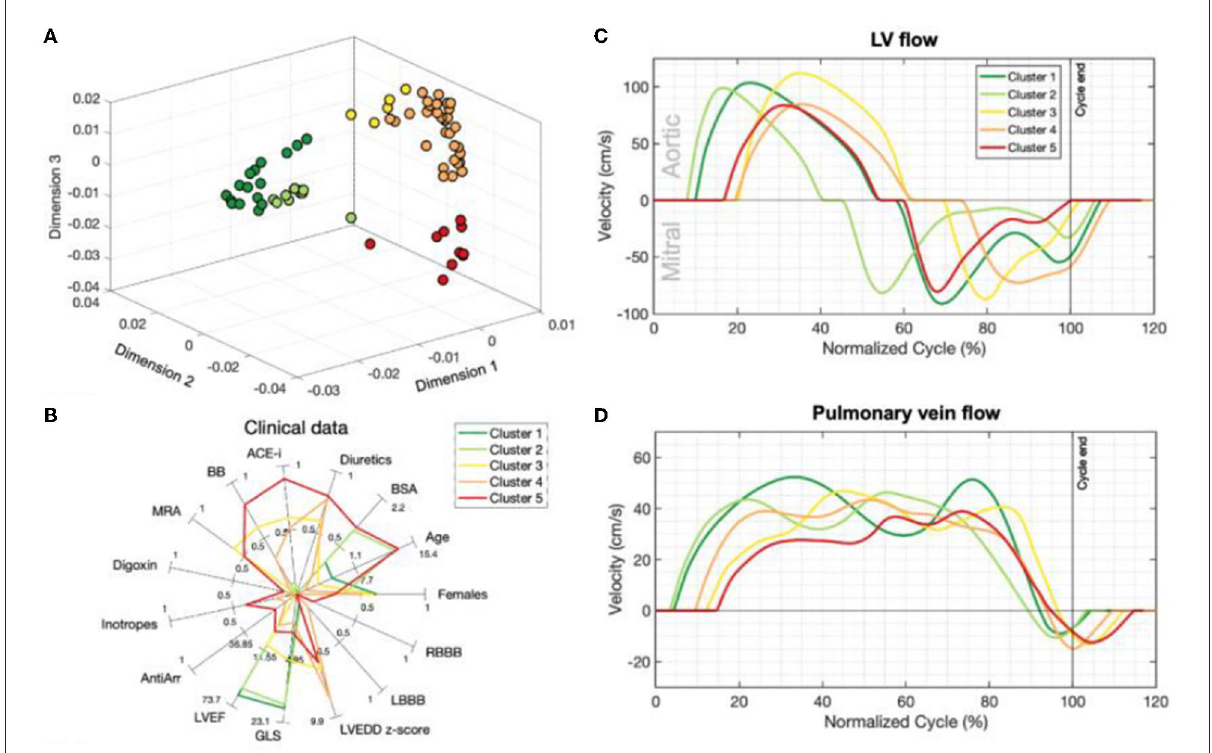
FIGURE3 Unsupervised learning techniques such as dimensionality reduction and cluster analysis have improved our ability to identify imaging phenotypes [Garcia-Canadilla et al. (15)]. (A) Non-parametric dimensionality reduction techniques (multiple kernel learning) quantify the similarity between patients based on their echocardiographic inputs (Doppler velocity and ventricular strain tracings). This plot is a representation of how patients are positioned by their similarities based on dimensionality reduction. K-means clustering then identified five separate groups of patients based on these similarities (different colors represent different clusters). (B) Each cluster has clinically distinct characteristics. Clusters 1 and 2 were healthy volunteers. Clusters 3–5 were DCM patients. In particular, cluster 5 had the oldest patients and had a relatively increased usage of oral and IV medications. (C,D) Representative mitral, aortic and pulmonary vein Doppler velocity patterns normalized for one full cardiac cycle for each group are seen here. Patients with DCM (Clusters 3–5) have relatively abnormal Doppler tracings compared to healthy volunteers (clusters 1–2). Figure adapted from Garcia-Canadilla et al.